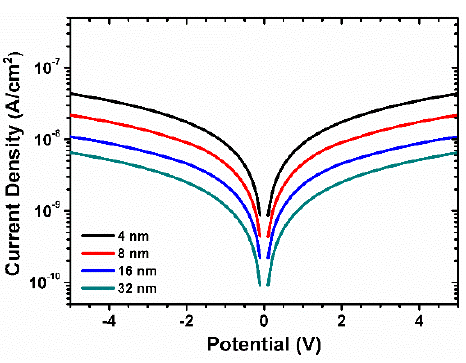
Figure 6. Current-voltage ( I-V ) response of films with different thicknesses at room temperature.